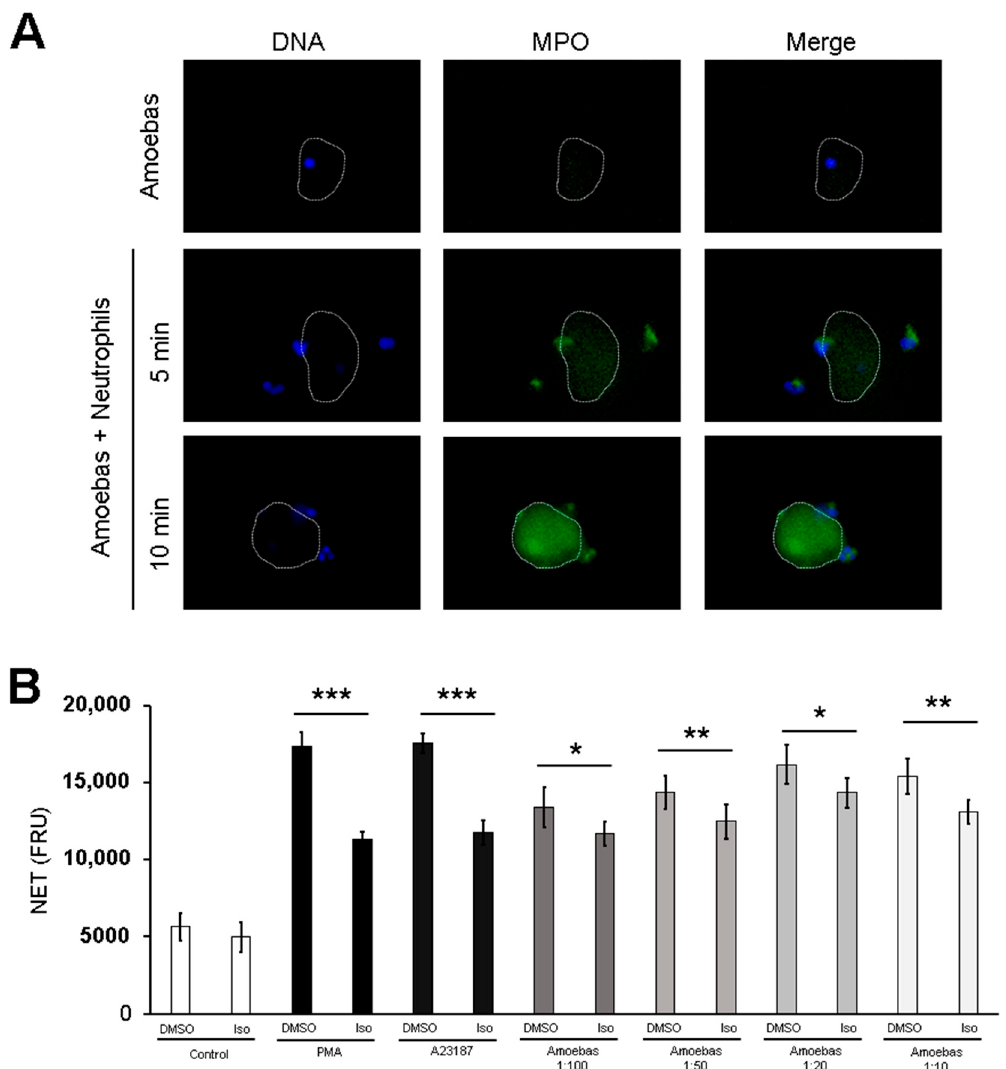
Figure 8. Extracellular MPO activity is required for NETosis induced by E. histolytica . ( A ) Neutrophils (2 × 10 5 ) were co-cultured with 1 × 10 4 E. histolytica trophozoites during 5 or 10 min. Cells were fixed and immunofluorescence was performed using anti-MPO antibody followed by anti-mouse IgG-FITC secondary antibody. DNA was counterstained with DAPI. Amoebas alone were used as a control. Trophozoites are indicated by doted white lines. Images were taken at 100× magnification. Scale bar 100 µm. ( B ) Neutrophils (1 × 10 5 ) were pretreated with 50, 100 and 200 µM isoluminol (Iso) or DMSO for 30 min. Posteriorly, cells were transferred to RPMI-1640 medium added with 5% FBS and 500 nM SYTOX ® Green and then stimulated with PMA (50 nM), A23187 (10 µM) or E. histolytica trophozoites at ratios of 1:100, 1:50, 1:20 and 1:10. Fluorescence was read after 4 h. NET amount is expressed in fluorescence relative units (FRU). Values are means ± SD of three independent experiments. * p < 0.05, ** p < 0.01, *** p <